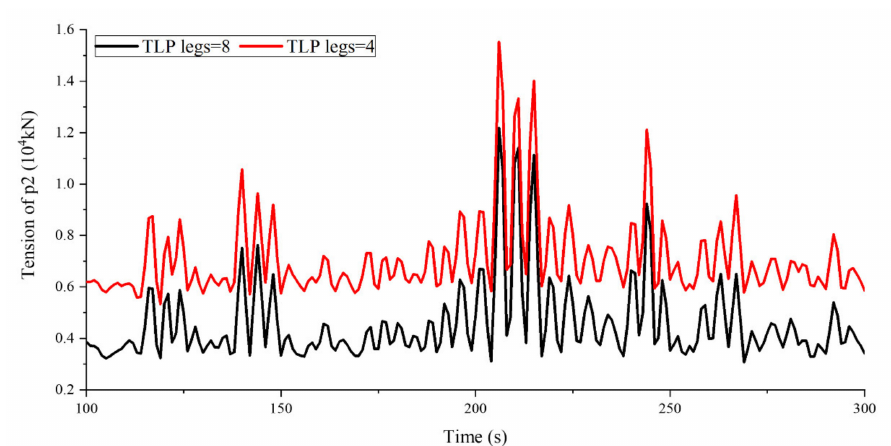
Figure 9. Roll under different tension leg arrangements.